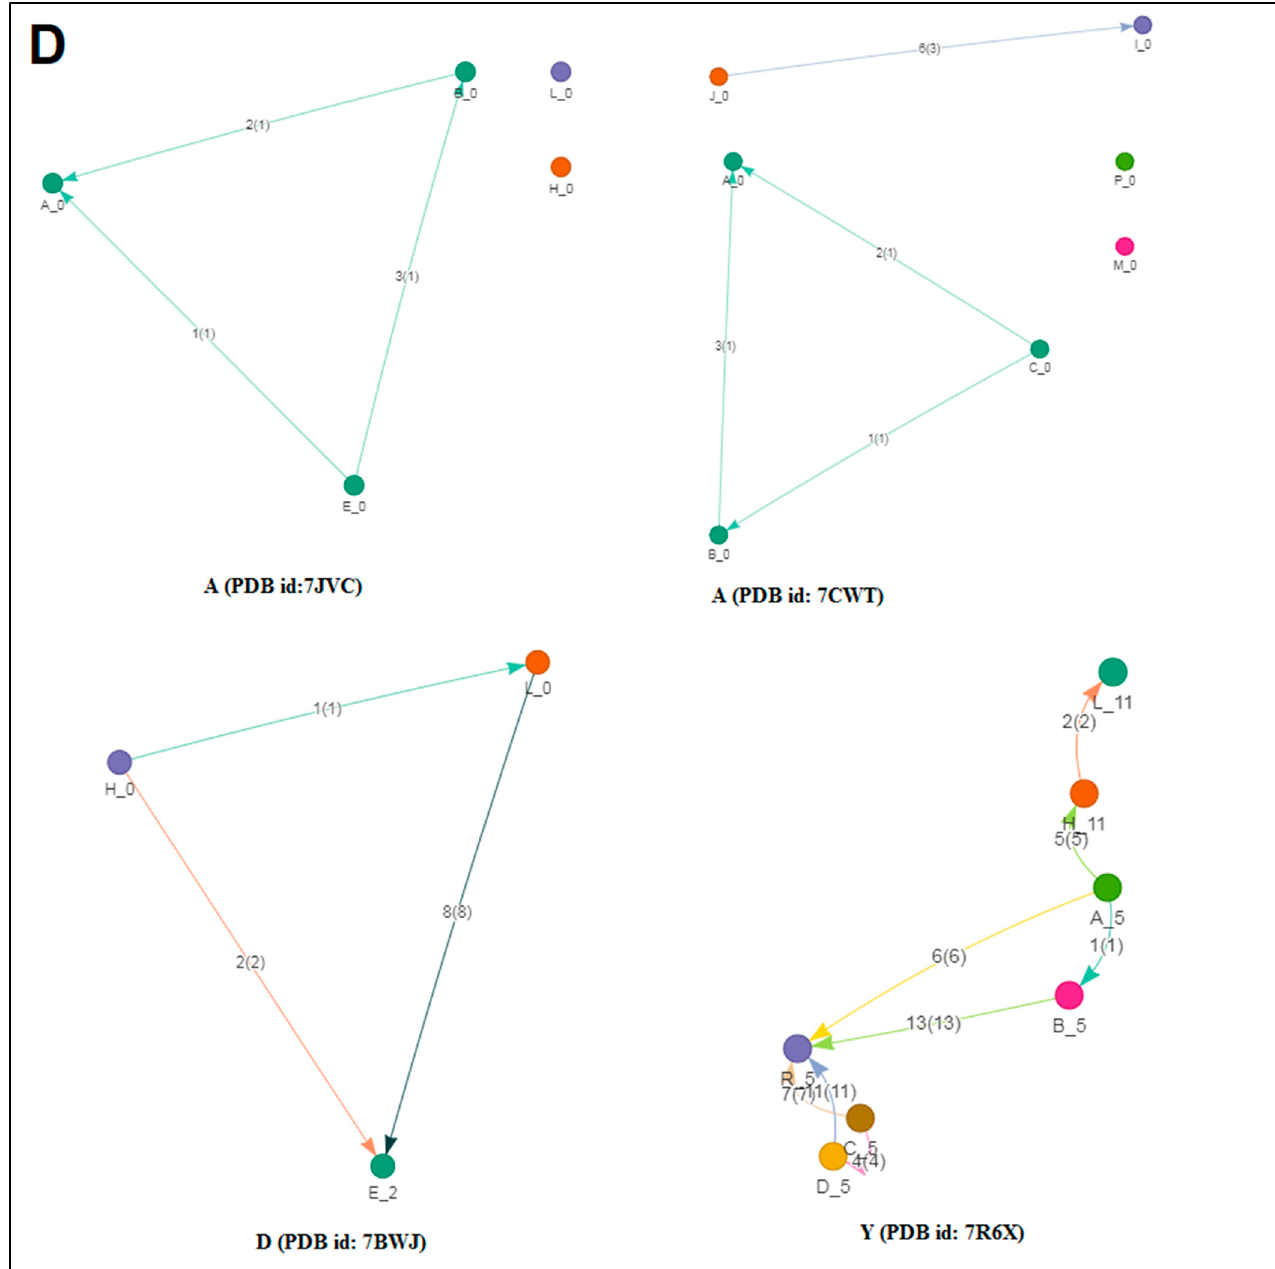
Figure 4. The schematic representation on the classification of evolutionary protein interface and the result of the study of protein alphabets of SARS-CoV-2 proteins and non-SARS-CoV-2 proteins. ( A ) Schematic representation of the classification of evolutionary protein interface study. ( B ) Clas- sification of evolutionary protein interface of each protein, which was used to develop the word “SARS-CoV-2”. ( C ) Classification of evolutionary protein interface of each protein, which was used to develop the word “COVID-19”. ( D ) Classification of evolutionary protein interface of four SARS-CoV-2 protein alphabets with antibodies/immunological or vaccine-associated roles used in this study. The study analyzed the structural pattern of 3D structures of each protein through the classification of evolutionary protein interface.